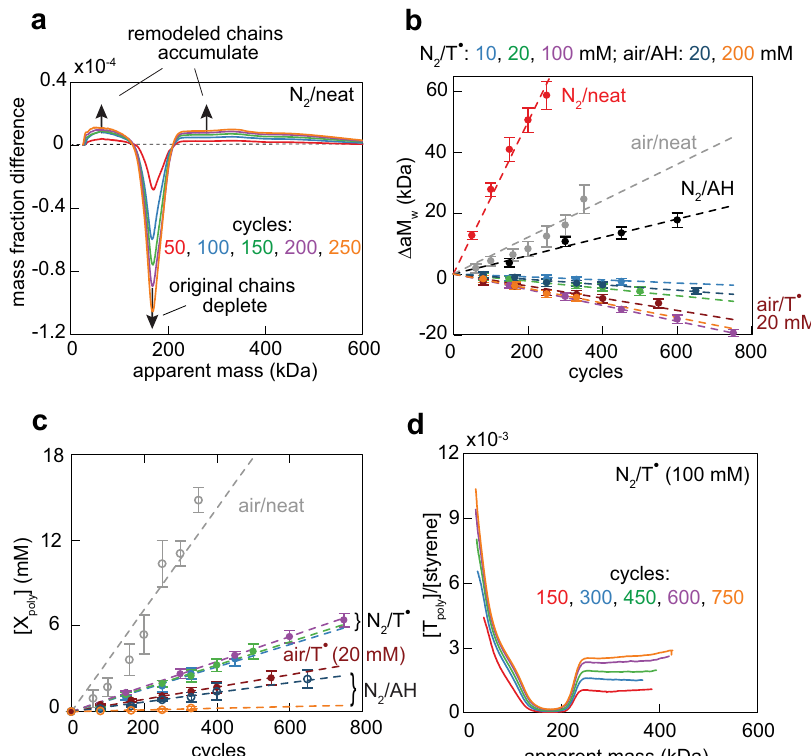
Fig. 2 Summary of experimental results. a Changes in the mass fraction of chains of each apparent mass relative to that in the initial sample of neat copolymer sheared under N 2 (see Supplementary Figs. 10, 11 for all absolute and differential aMMDs and Supplementary Figs. 12 – 14 for corresponding SECs). b Changes of apparent M w of sheared samples. c The concentration of polymer-bound T or OOH moieties, [X poly ], ( fi lled and open circles, respectively), as a function of the number of shearing cycles. Note that for aerobically sheared T-containing sample, only [T poly ] was measured. Data sets not individually labelled in ( b, c ) are identi fi ed in the legend at the top of ( b ). The error bars de fi ne the 2 σ con fi dence intervals. d The number of polymer- bound T moieties per styrene, [T poly ]/[styrene], for chains of each apparent mass in anaerobically sheared copolymer containing 100 mM T (cid:129) (see Supplementary Fig. 16 for the other samples). The low [T poly ]/[styrene] ratios at 160 – 200 kDa re fl ect the dominance of intact chains at these masses. All data illustrated here and the SI is provided in the Supplementary Data fi le (see data availability